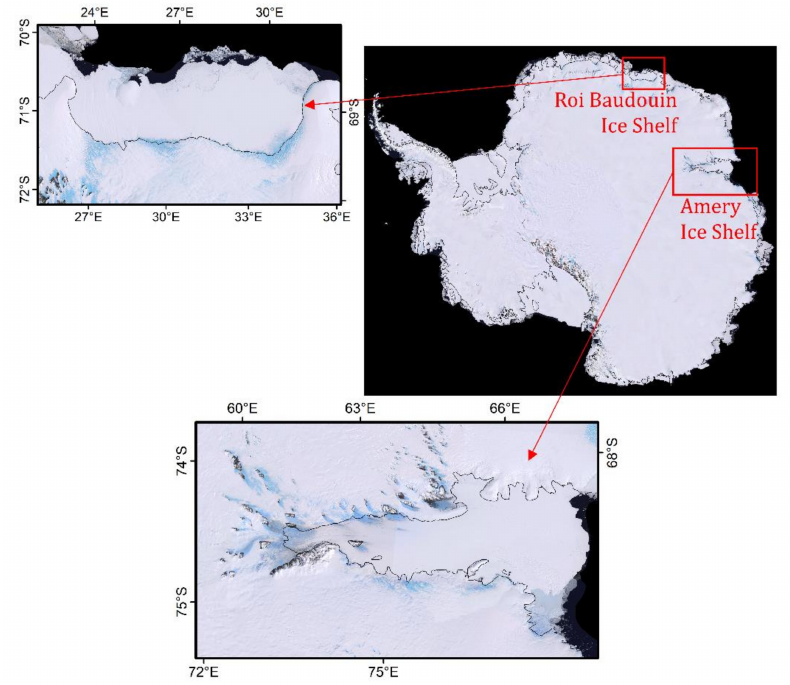
Figure 1. Amery Ice Shelf and Roi Baudouin Ice Shelf locations, with the grounding line (separating floating and grounded ice) shown in black. Imagery is from the Landsat Image Mosaic of Antarctica